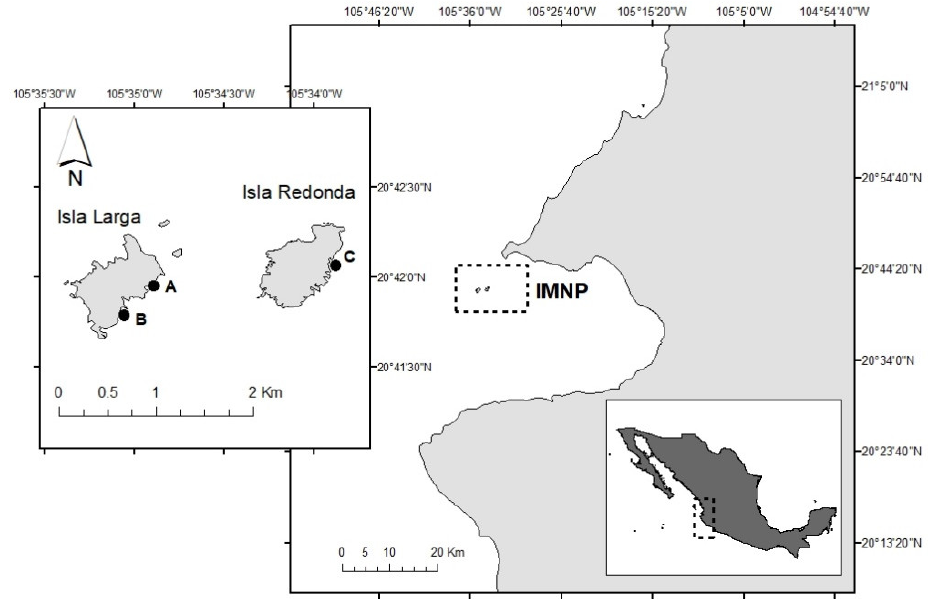
Figure 1. Study area: Islas Marietas National Park (IMNP), Nayarit, Mexico. All sampling sites harbor a high Pocillopora sp. coverage: (A) Restoration Zone (20.698860° N, 105.580997° W) and (B) Cueva del Muerto (20.697389° N, 105.582806° W) at Isla Larga, and (C) Pavonas Platform (20.700908° N, 105.565304° W) at Isla Redonda.